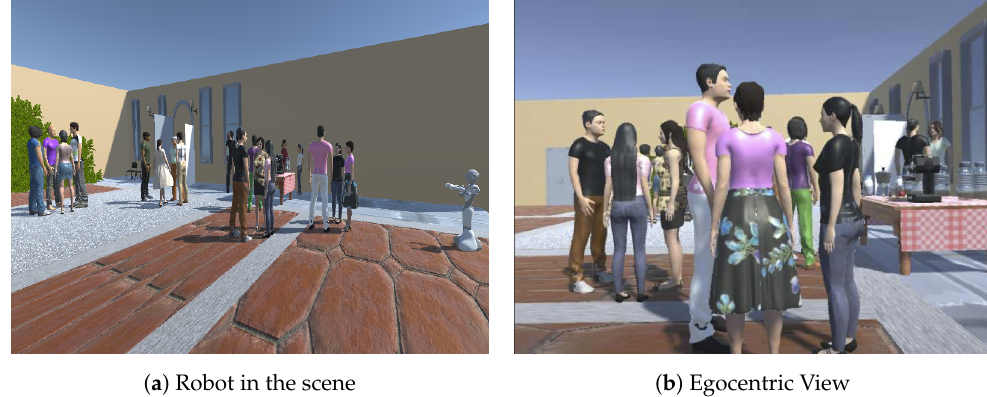
Figure 9. Images from Scene 1, ( a ) virtual Pepper robot is facing the scene where VAs are interacting with each other. ( b ) The egocentric view of the scene from the robot’s camera.